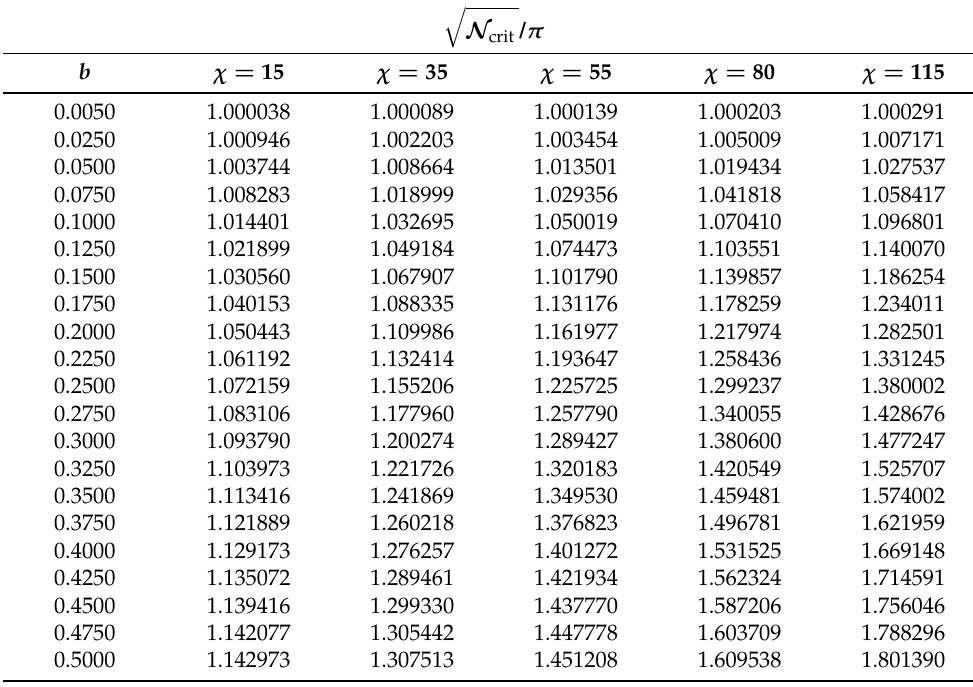
Table 7. The critical forces of PssP beams if χ = 15, . . . ,115.